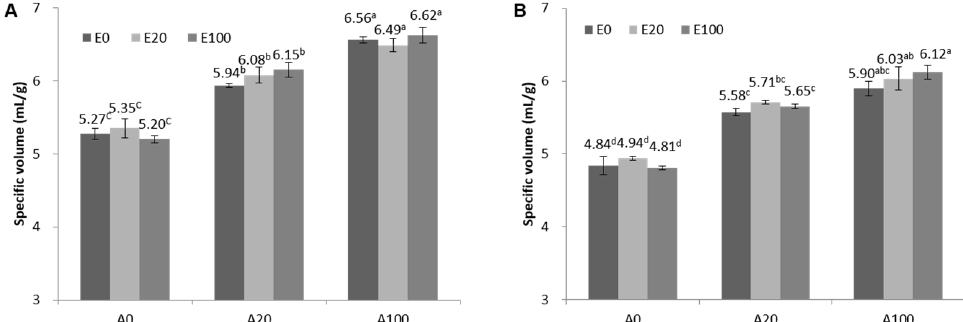
Figure 3. Specific loaf volume profiles of fresh and frozen bread doughs formulated with Aamyl and Exyl. ( A ) FSDB; ( B ) FZDB. The values with di ff erent letters ( a,b,c,d ) are significantly di ff erent at p < 0.05 within a clustered group of both panels A and B.